Question: Provide a one-line summary of what is displayed.
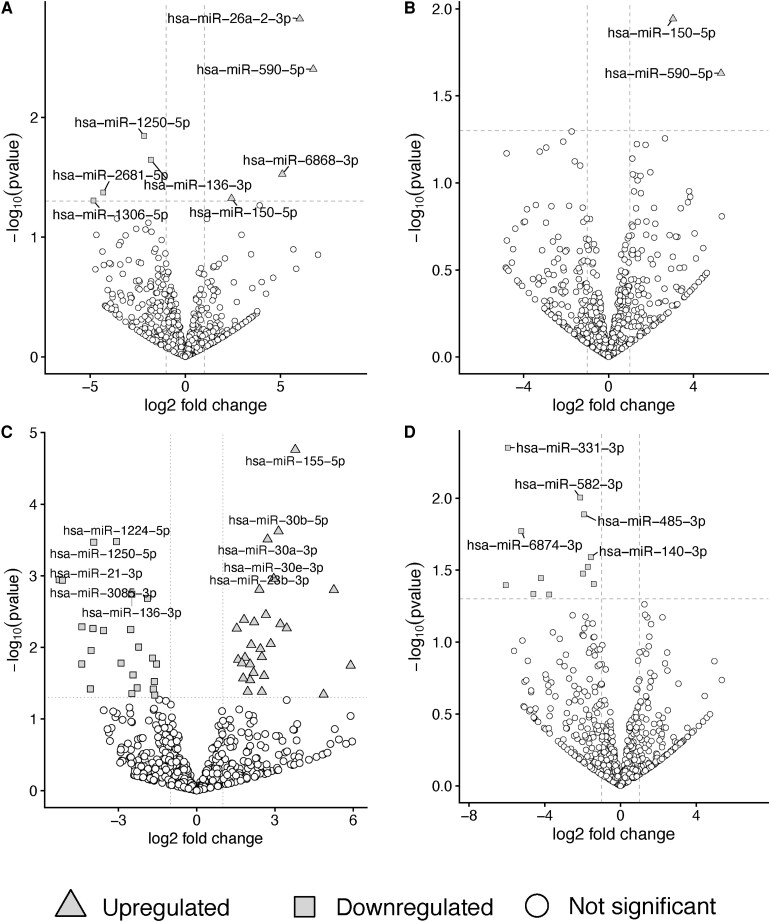
Answer: BDsEV miRNA cargo microenvironment variation compared with no disease control samples. Volcano plots displaying the differential expression of ( A ) AD, ( B ) FTD- GRN , ( C ) FTD- MAPT and ( D ) FTD- C9orf72 BDsEV human (hsa) miRNA cargoes compared with no disease samples with log2FC plotted against log10 p values. DESeq2 was ran in R which applies a negative binomial generalized linear model with Wald testing (sample size n = 3, biological replicates plotted). Nominally significant upregulated (triangle plot), downregulated (square plot) and not significant (circular) miRNAs are plotted, as no miRNAs survived FDR testing (with the top 5 up and downregulated miRNA labelled). Dashed lines represent log2FC of 1 and −1 and a −log10p of 1.3 ( P < 0.05).